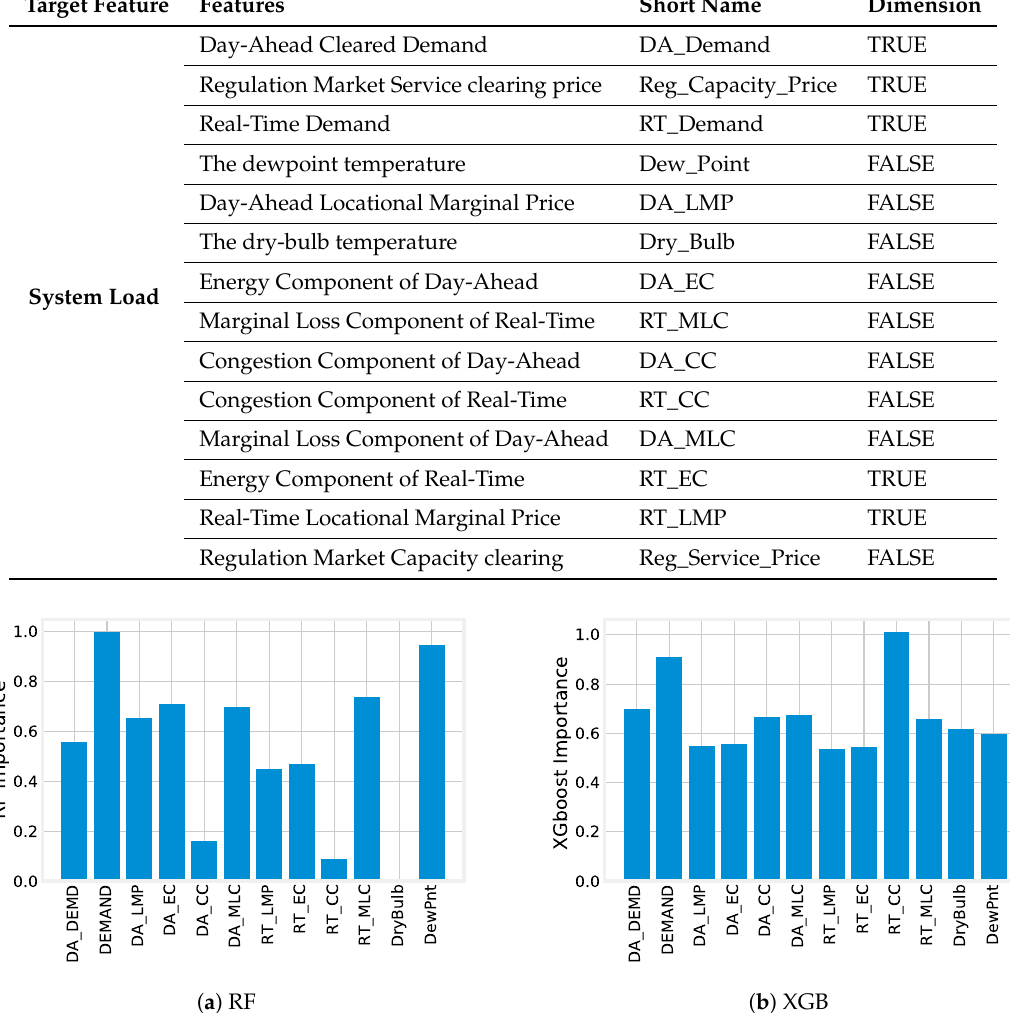
Figure 9. Feature importance calculated by ( a ) Random forest ( b ) Extra Gradient Boosting.